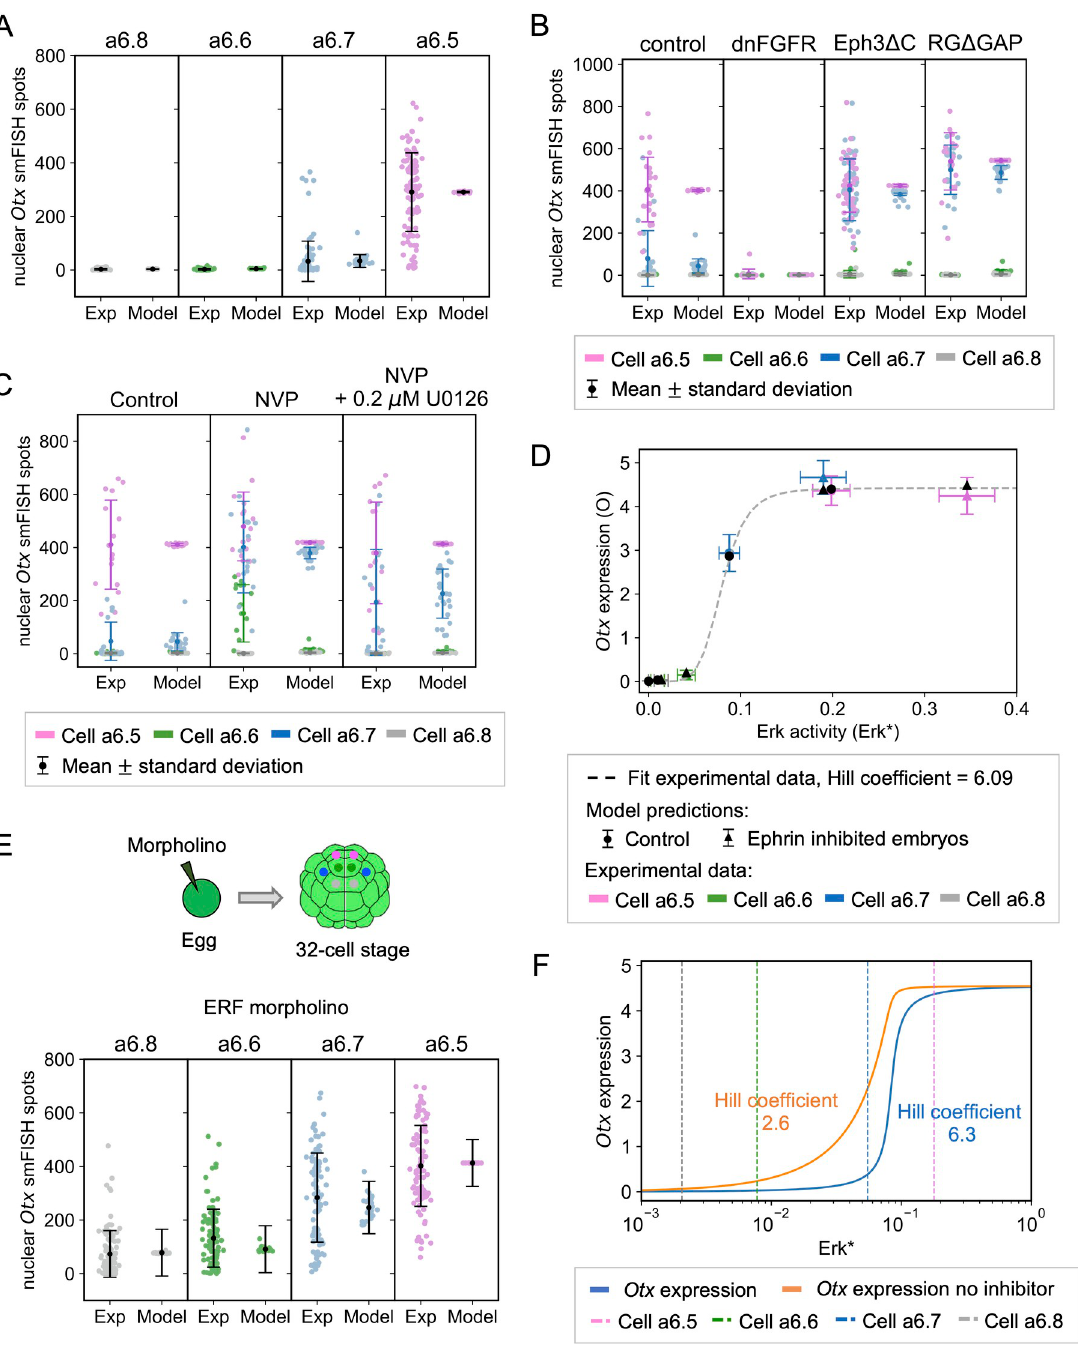
Fig 3. Control of Otx expression by ERK. (A) Levels of Otx expression in the a6.5, a6.6, a6.7 and a6.8 cell types as measured by single ). Each point represents a single molecule fluorescence in situ hybridization (smFISH, left) and computed with the model (right, Otx smFISH cell and modeling results are computed using the measured values of S 1 . Means and standard deviations are shown in black. C = 66 and D = 2.75 in Eq (18). (B) Otx expression in control, dnFGFR, Eph3 Δ C and RG Δ GAP injected embryo halves. Left and right columns show experimental Otx smFISH spots and computed Otx , respectively. Results for the four cell types are shown in the same columns with smFISH different colors. Each dot represents a single cell. Injection of dnFGFR, Eph3 Δ C and RG Δ GAP were modeled by considering R tot = 100, Q tot = 10, and V rg = 0.01, respectively. In Eq (18), C = 92 for the control embryos and for dnFGFR injected embryos, C = 95 for Eph3 Δ C injected embryos and C = 122 for RG Δ GAP injected embryos. D = 1.5 for the control and dnFGFR injected embryos, D = 2.71 for Eph3 Δ C and D = 1.61 for RG Δ GAP injected embryos. (C) Effect of the ephrin/Eph inhibitor NVP on Otx expression in the four cell types. On the left, control; in the middle, NVP-treated embryos; on the right, embryos treated with NVP and with the MEK